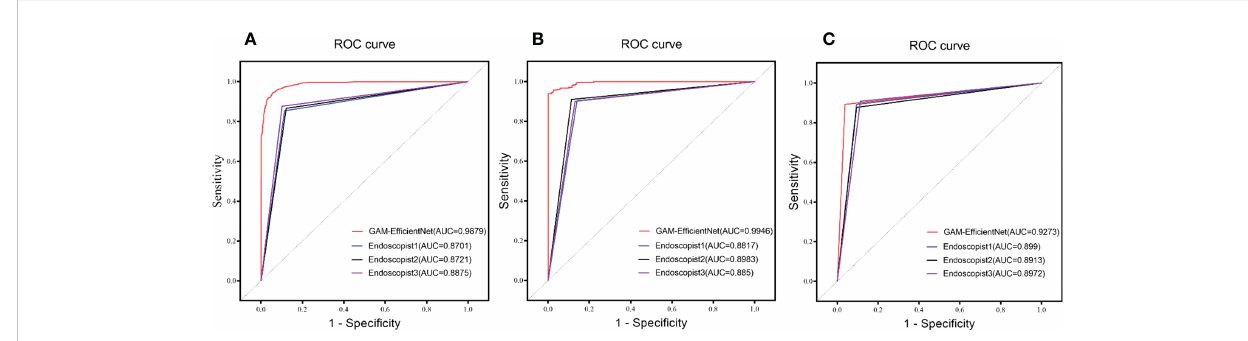
FIGURE 5 ROC Curve of GAM-Ef fi cientNet and endoscopists. (A) Internal test set; (B) External Test Set; (C) Video Test